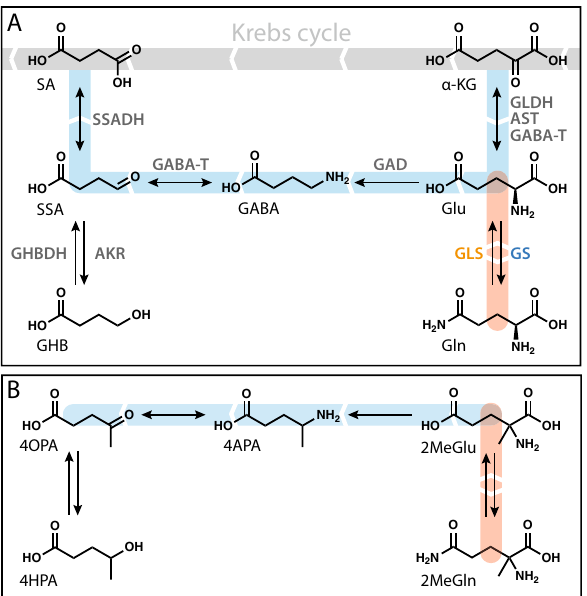
Figure 1. l-Glutamate is involved in the GABA shunt (blue arrows) off of the Krebs cycle and in the glutamate- glutamine cycle (red arrows) ( A ). Glutamate amidation proceeds primarily in astrocytes (blue font), while the reverse reaction occurs in neurons (orange font). For simplicity the transport steps are not shown. Hypothetical metabolic scheme of 2MeGlu into methyl analogues of Glu metabolites ( B ). SA and α-KG have no exact analogues and are not shown in the figure. AKR aldo–keto reductase, AST aspartate transaminase, GABA-T GABA transaminase, GAD glutamate decarboxylase, GHBDH gamma-hydroxybutyrate